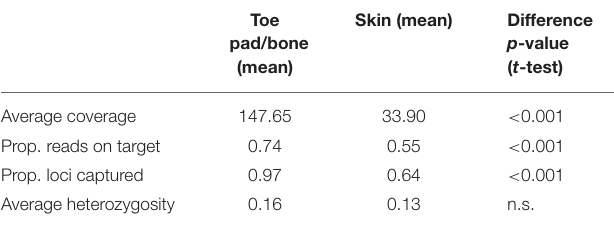
TABLE 2 | Sequencing success of different tissue types for dual-indexed rodent